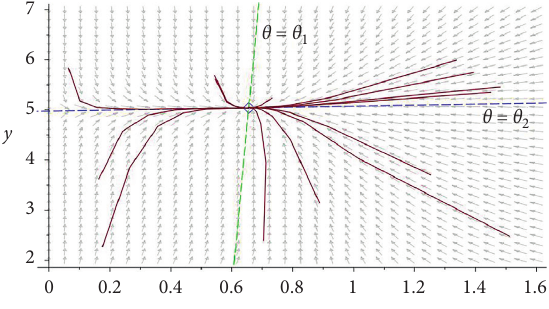
Figure 1: Phase diagrams around an unique stable node E characteristic direction θ � θ